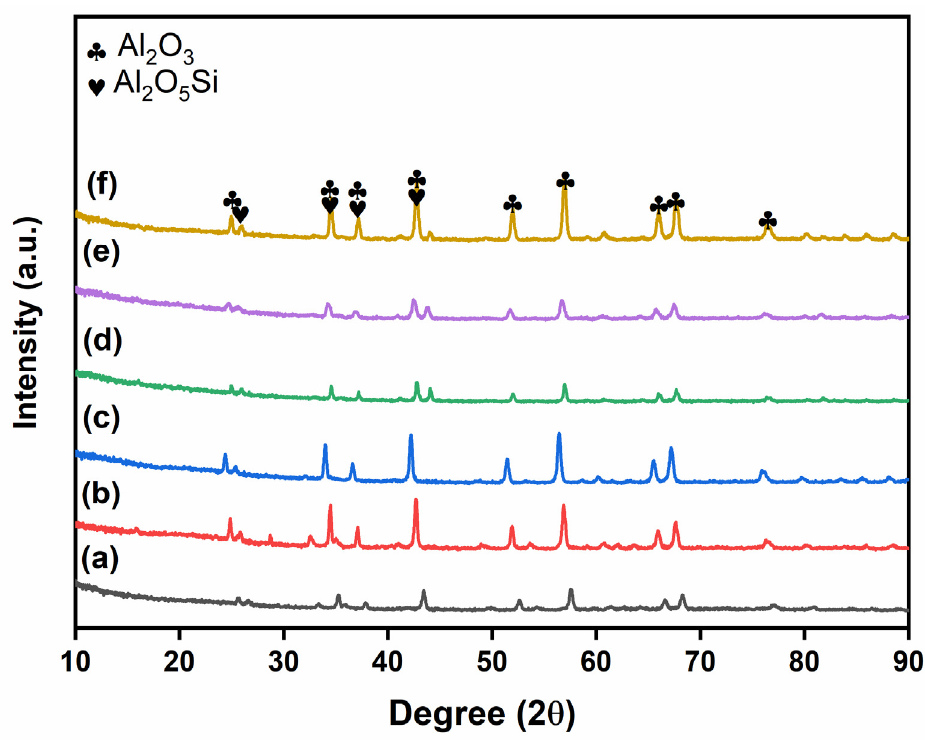
Figure 2. XRD patterns of glass-ceramics with Al 2 O 3 additive: (a) 30Al-O, (b) 40Al-O, (c) 50Al-O, (d) 30Al-Ar, (e) 40Al-Ar, and (f) 50Al-Ar.